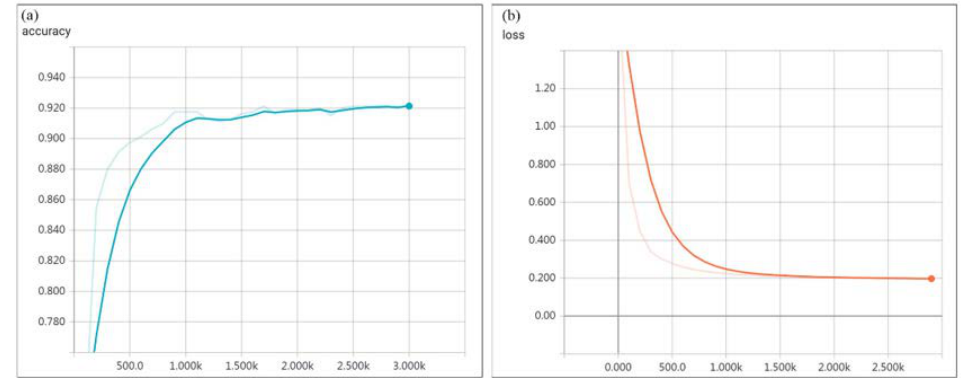
Figure 6. Scalar visualisation of the DNNClassifier model: ( a ) accuracy value ( b ) and loss